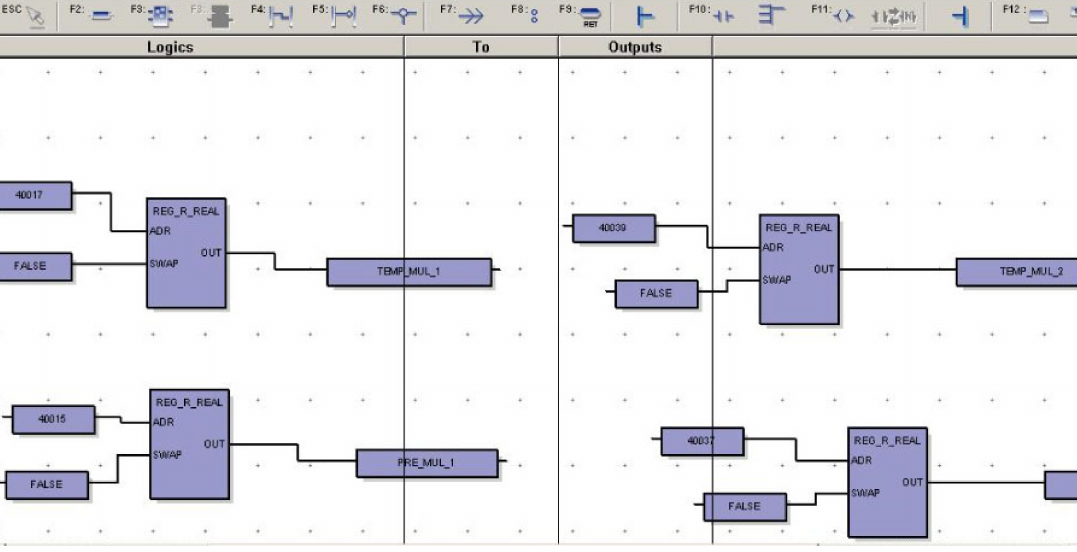
Figure 12. Logic for reading operational